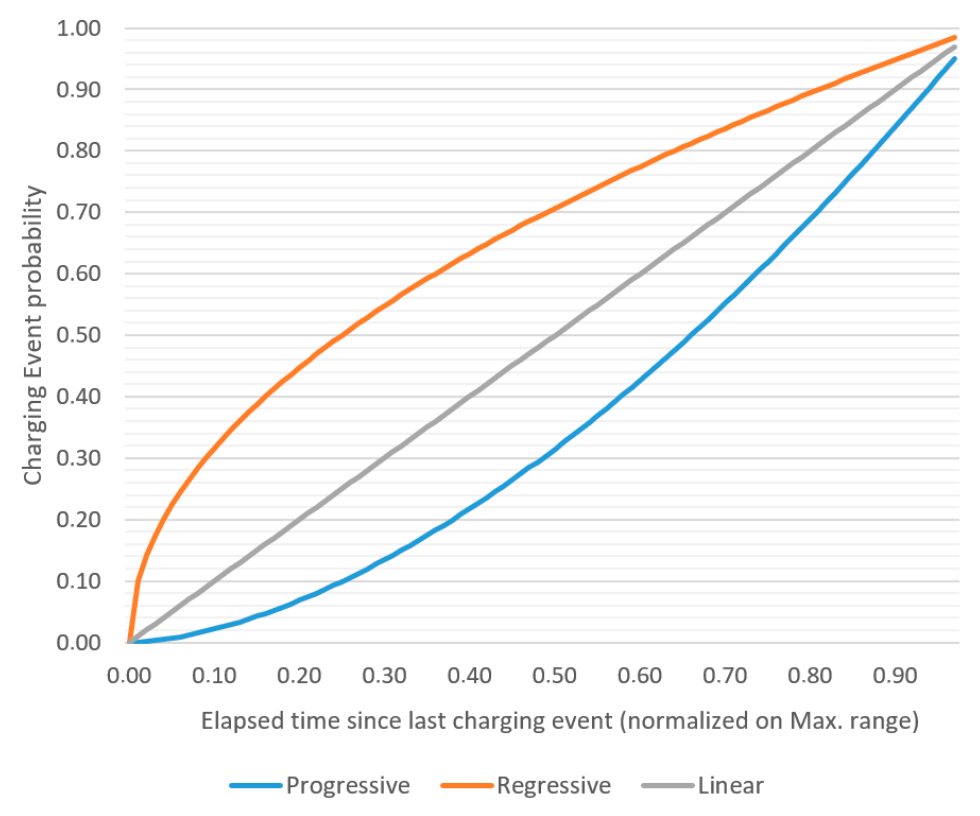
Figure 3. Scenarios for charging events probability distribution.